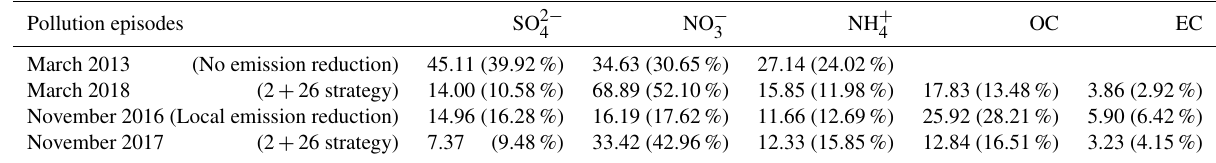
Table 5. The mean mass concentration and percent of major PM 2 . 5 components during four pollution episodes (µgm − 3 ). Pollution episodes